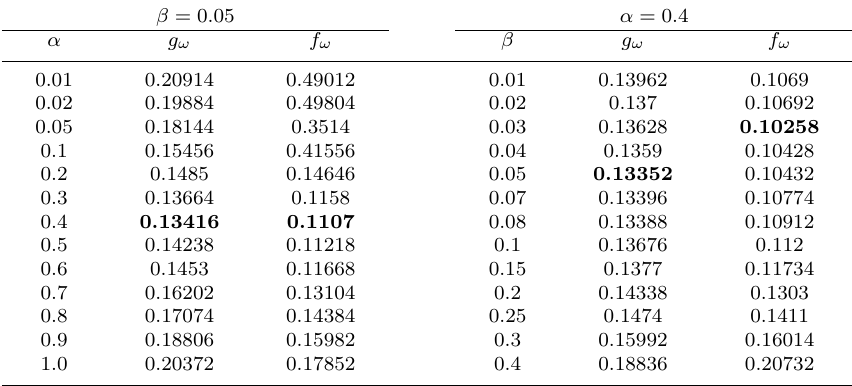
Table 10. Average values of error probabilities dependency on α and β . Matrix ˜ P 1 . β = 0 . 05 α = 0 . 4 α g ω f ω β g ω f ω 0 .